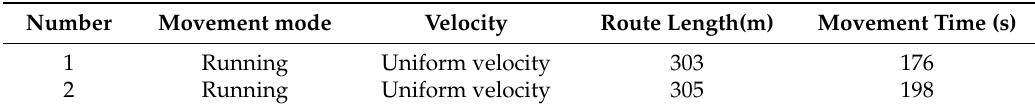
Table 3. Long-distance running experiments-related parameters.